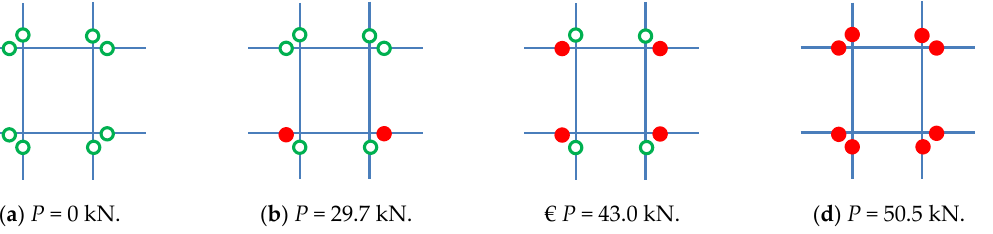
Figure 25. Failure procedure of IC_OB_F specimen.